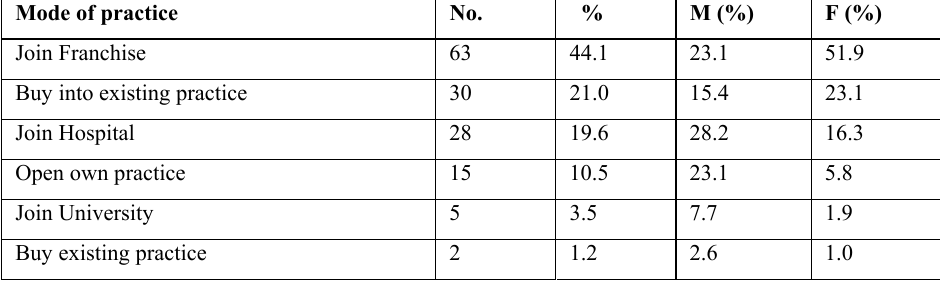
Table 5: Modes of practice considered to be more advantageous to enter practice. Number, percentage of respondents and within gender percentages are shown.